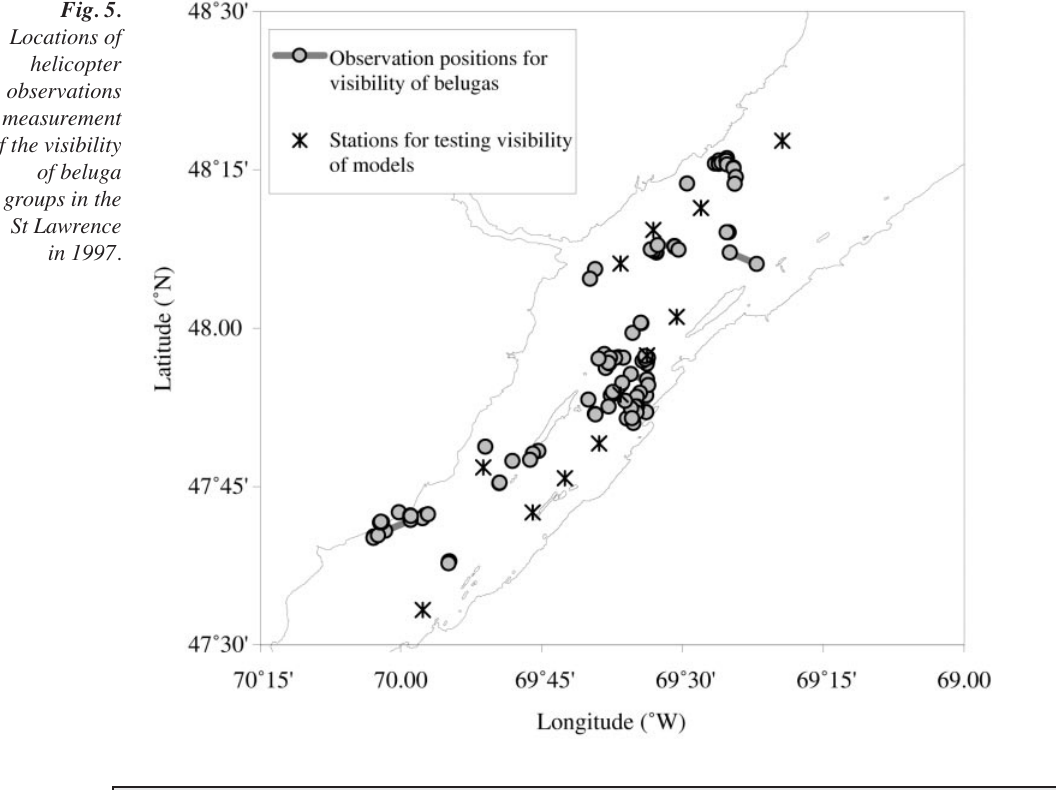
Table 1 . Correction factors for aerial survey counts to obtain total population numbers of mon- odontid whales estimated from studies in the St Lawrence and in the Arctic between 1973 and